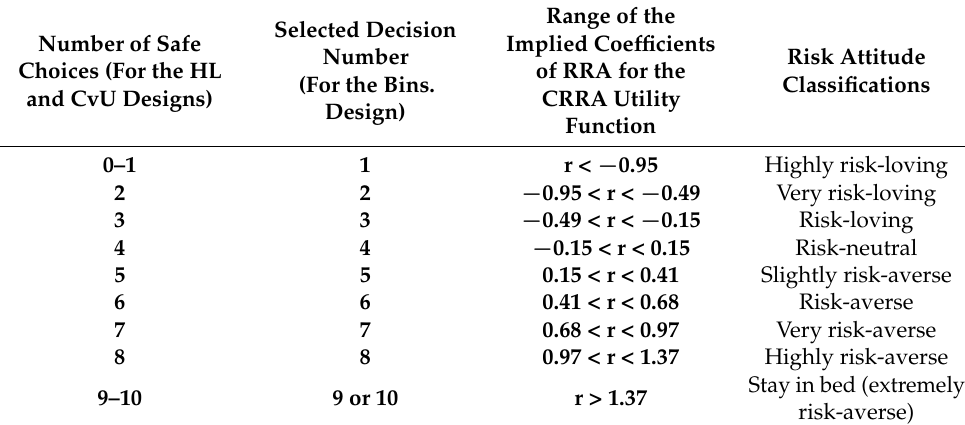
Table 1. Risk aversion classifications based on options